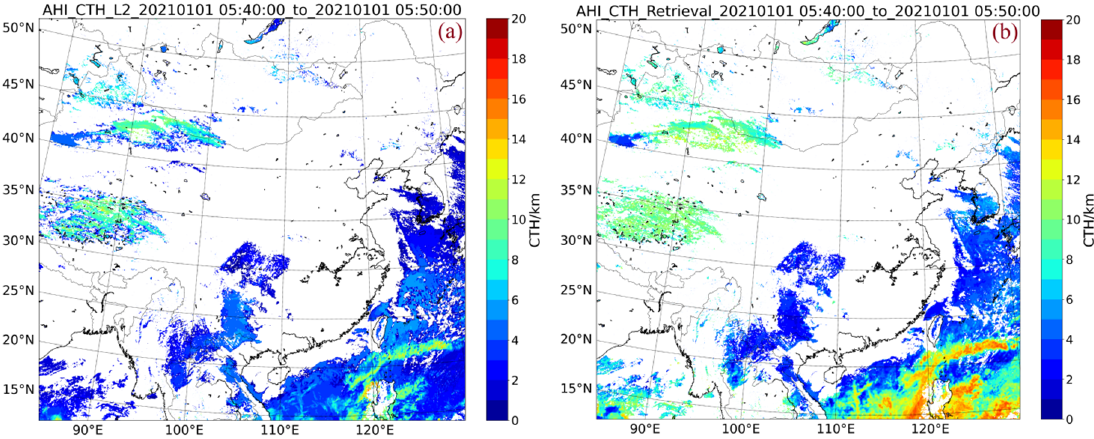
8 of 19 Figure 3. Model training process based on XGBoost. 3. Result 3.1. Case Analysis